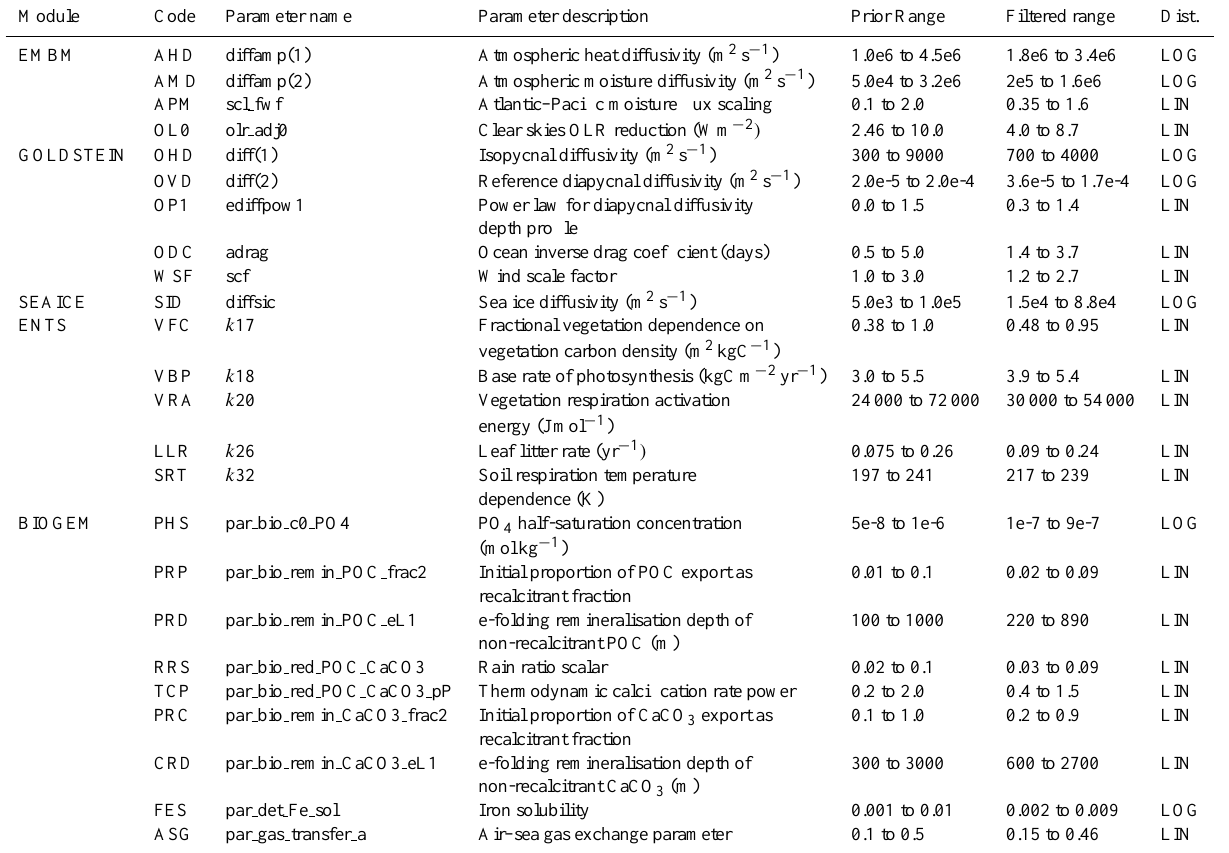
Table 1. Varied model parameters of the simulation ensemble. The prior ranges are the input parameter ranges to the precalibration. The filtered ranges are the 10th and 90th percentiles of the parameter distributions of the precalibrated (EFPC) ensemble, demonstrating the constraints (or otherwise) on parameter values that are imposed by the plausibility